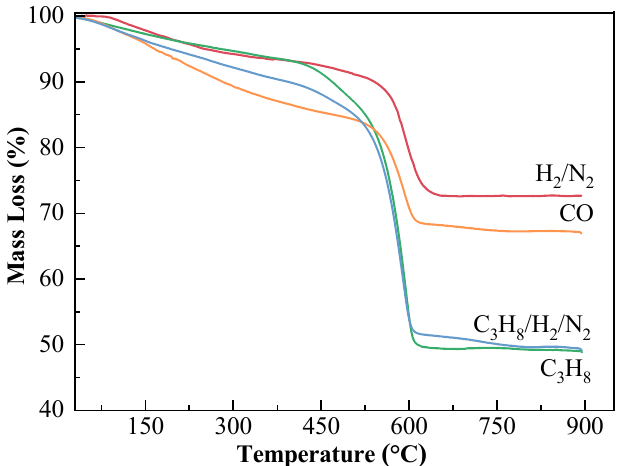
Figure 7. TG curves of the used PtIn/MAZ catalytic system reduced with different atmospheres (reduction conditions: T = 600 °C, t = 2.5 h; reaction conditions: T = 600 °C, WSHV = 3 h − 1 , atmospheric pressure in the gas mixture of C 3 H 8 :H 2 :N 2 molar ratio = 8:7:35 for 17 h).